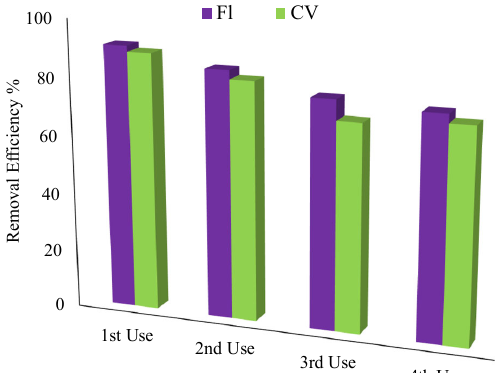
Figure 11. Effect of regeneration cycles on the removal of Fl and CV from aqueous solution using Ar-MSNPs. Removal conditions—adsorbent amount: 0.1 g, Fl concentration: 20 ppm and pH = 2, CV concentration: 100 ppm and pH = 13.